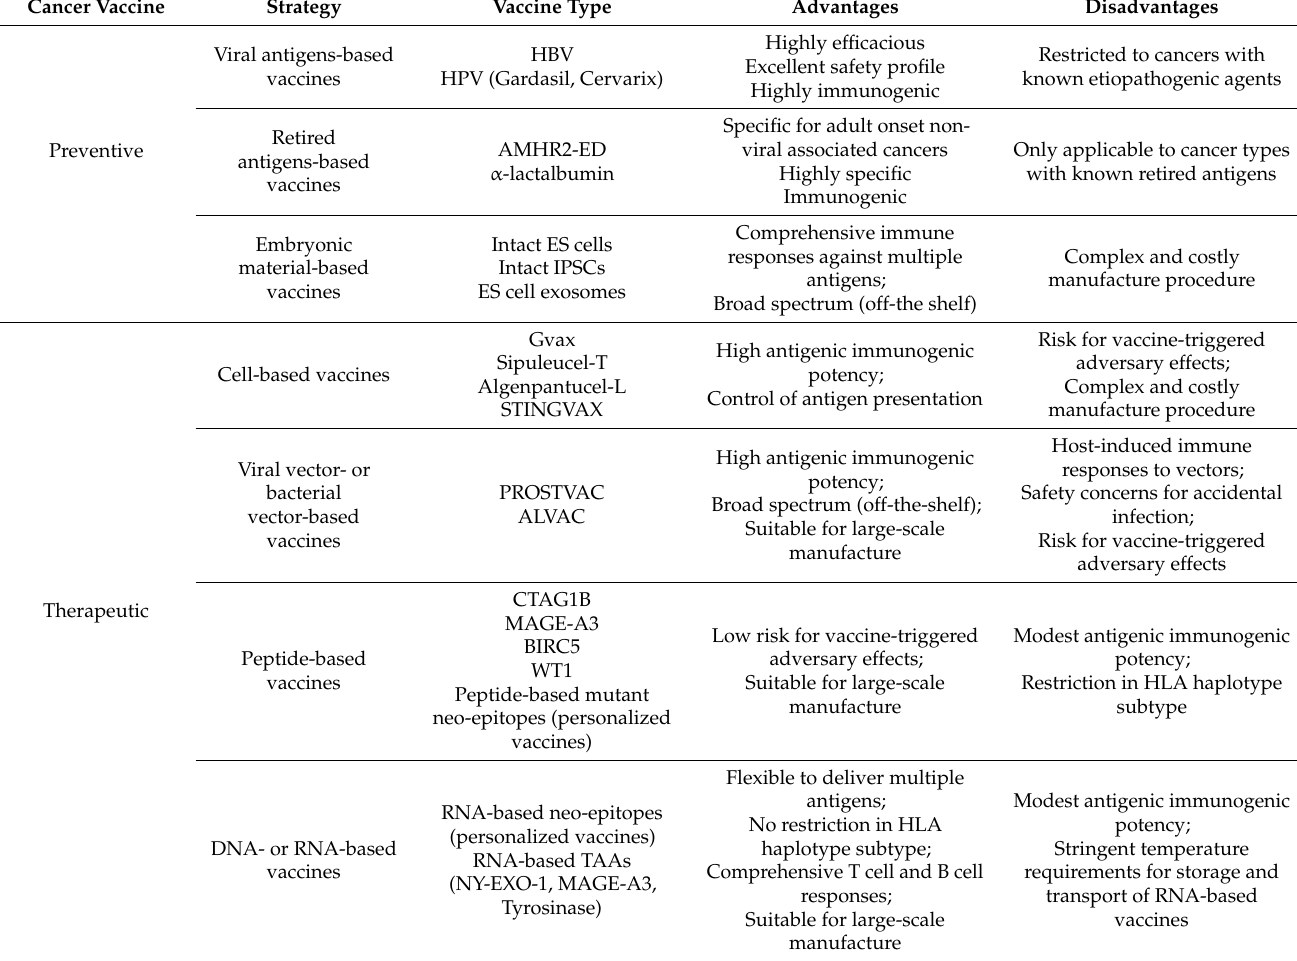
Table 1. Various anti-cancer vaccines including prophylactic and therapeutic vaccination strategies. Cancer Vaccine Strategy Vaccine